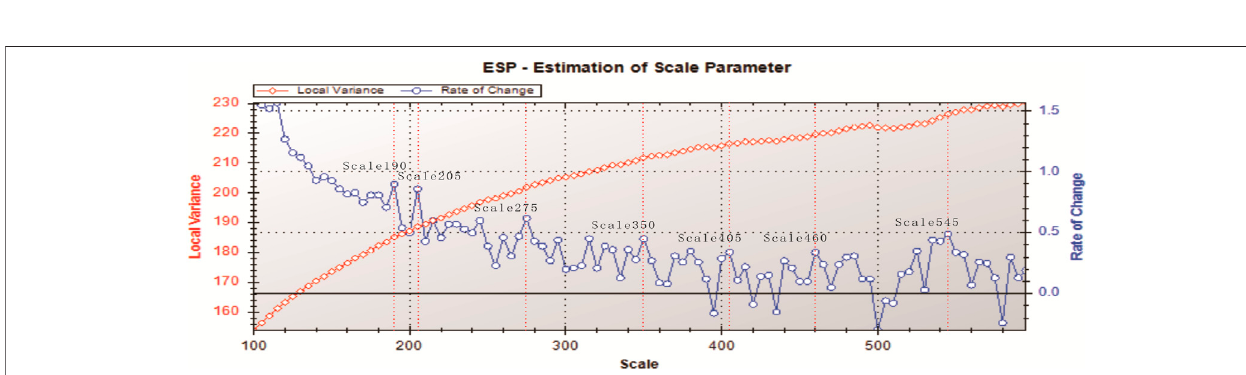
FIGURE 6 | Interpretation signs in GF-2 image. (A) Badlands, (B) coal gangue, (C) coal heap, (D) cultivated land, (E) other construction, (F) residential areas, (G) vegetation, and (H) water bodies.